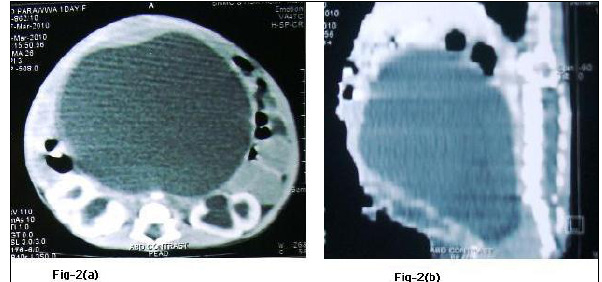
Figure 2 (a, b): CT images showing severe hydrometrocolpos.